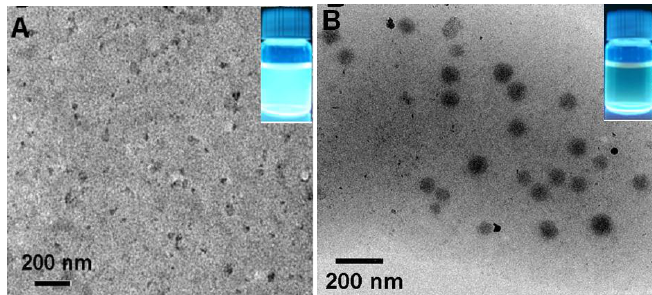
Figure 1. Transmission electron microscopy (TEM) images of polysaccharide-based NSs prepared from starch ( A ) and chitosan ( B ). Insets show the fluorescence photographs for the polysaccharide-based NSs in aqueous solution. Excitation wavelength for each sample in the inset pictures is 312 nm.